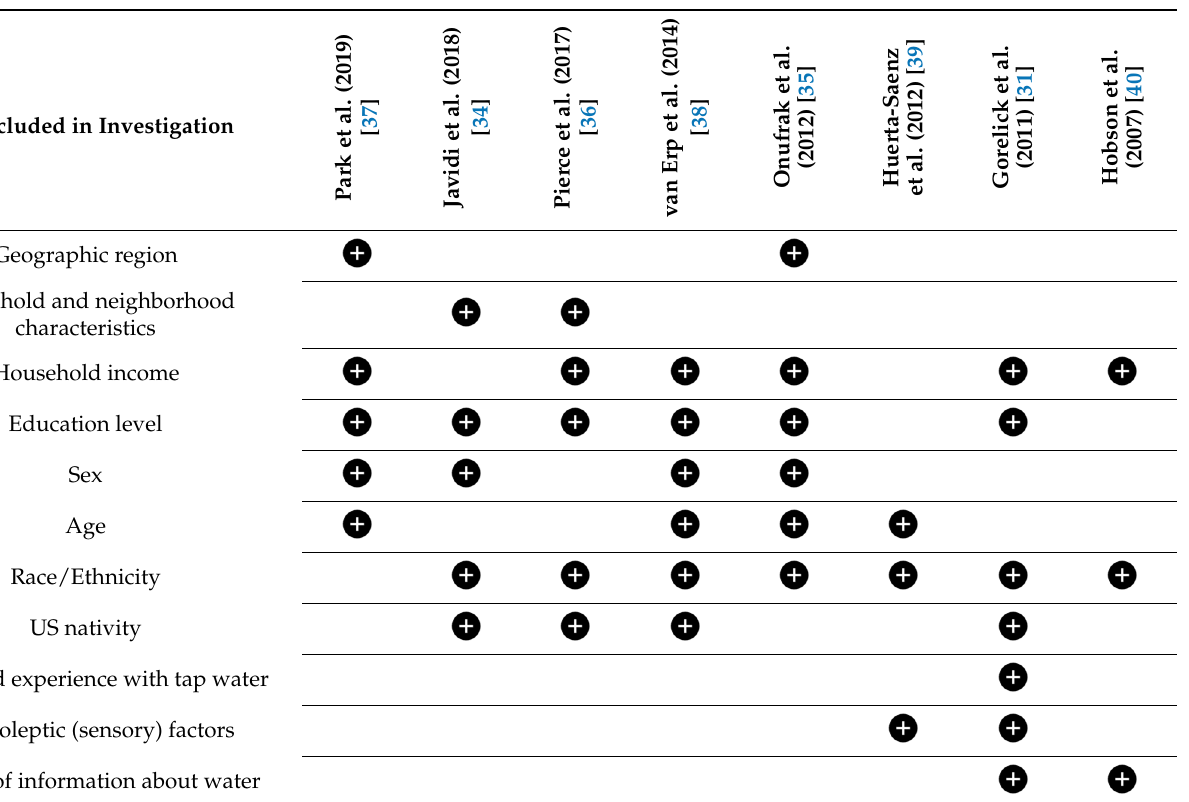
Table 4. Predictors included in investigations evaluating perceptions of tap water safety in US Latinx adults.